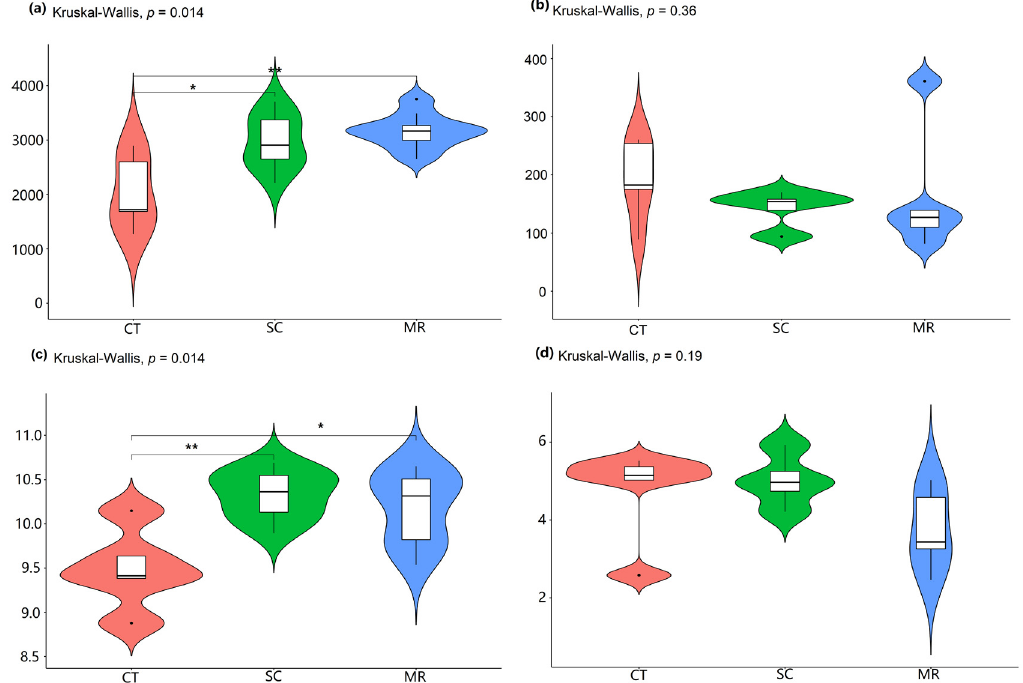
Figure 1. Differences in alpha diversity indices of bacteria (( a ). Chao1; ( c ). Shannon) and fungi (( b ). Chao1; ( d ). Shannon). One asterisk (*) represents significant difference ( p < 0.05) and two asterisks (**) represent highly significant difference ( p < 0.01) between treatments.